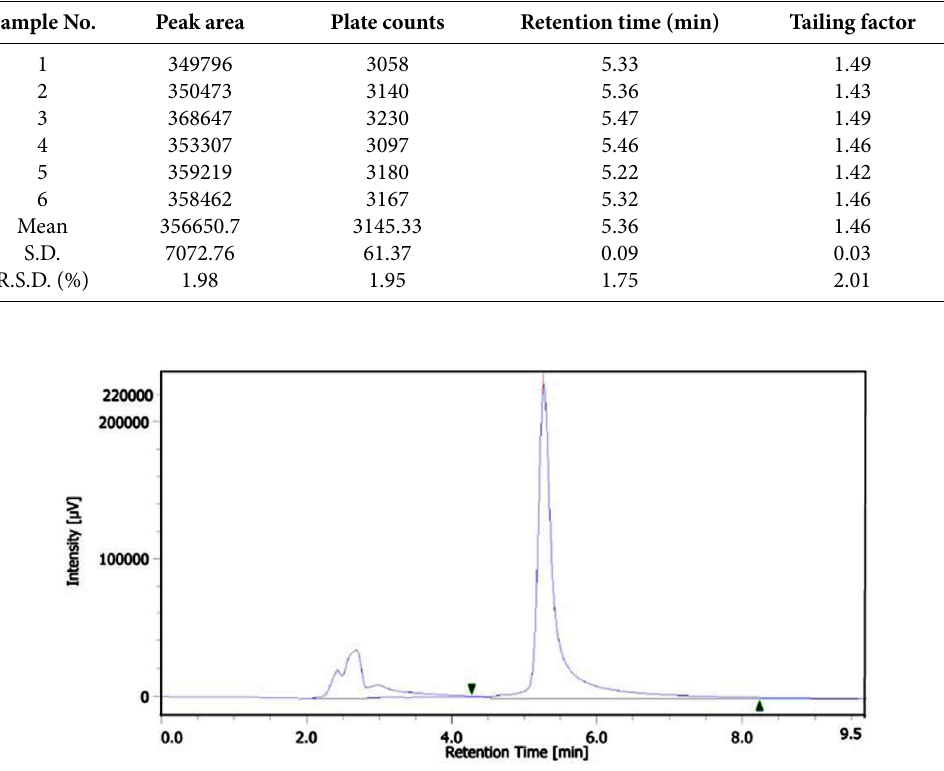
Fig. 1. HPLC chromatogram of curcumin in rat